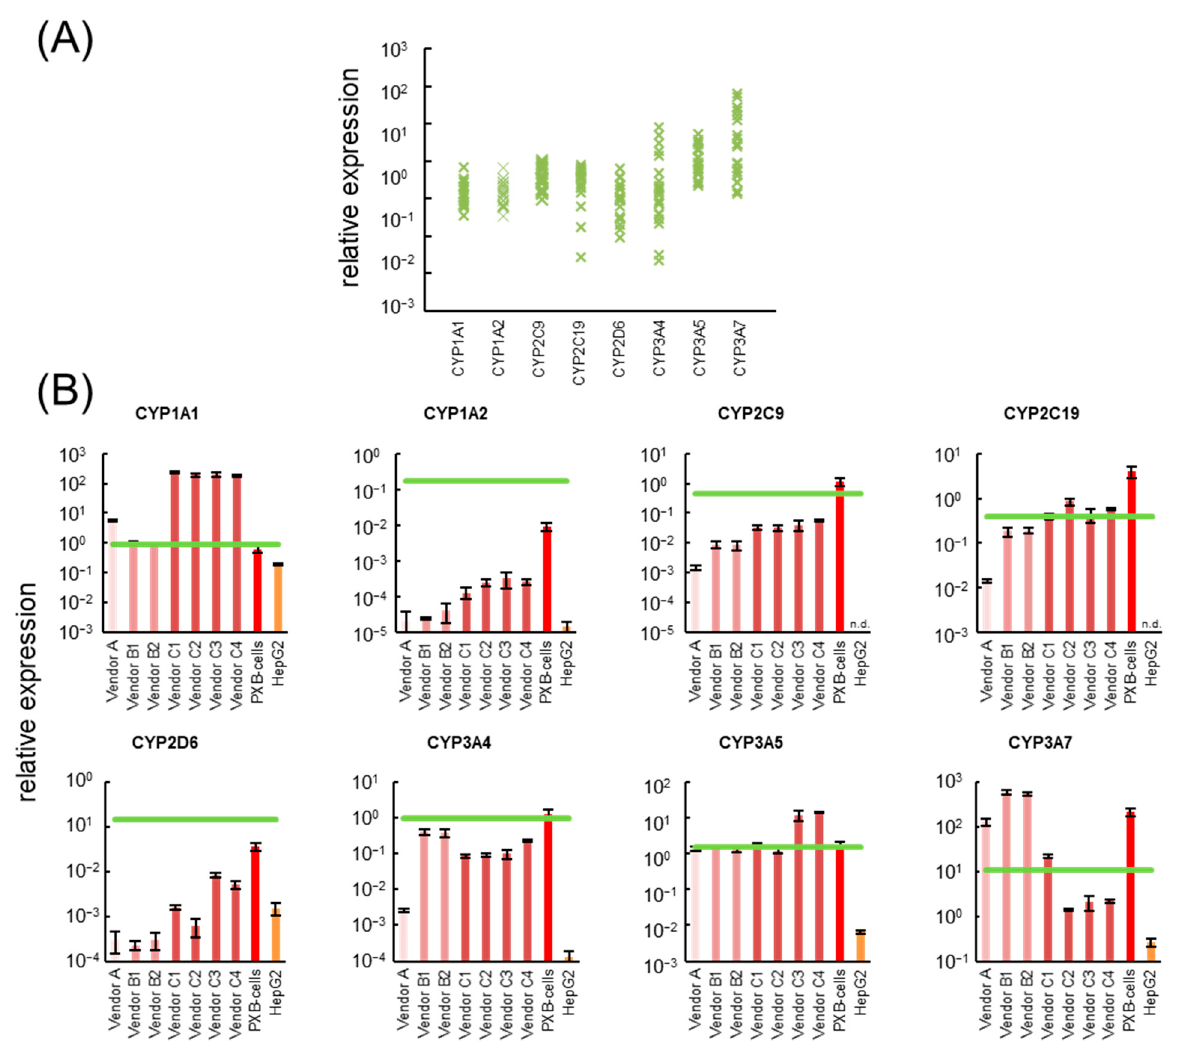
Figure 1. Comparison of the gene expression levels of cytochrome P450 ( CYP ) in cell source candidates for the liver-MPS (hepatocyte-like cells derived from human induced pluripotent stem cells, PXB-cells, and HepG2 cells) with the minimum and maximum values of the expression in 22 lots of cryopreserved human hepatocytes (cryoheps). ( A ) Distribution of CYPs expression levels in 22 lots of cryoheps. ( B ) The bars show the gene expression levels of CYPs in cell source candidates for the liver-MPS. The green line shows the average value of the expression in 22 lots of cryoheps. Pooled RNA from human liver was used for the standard curve, and the expression level was set as one. The relative expression level was calculated using the equation of the line for the standard curve. n = 3. n.d, not detected.